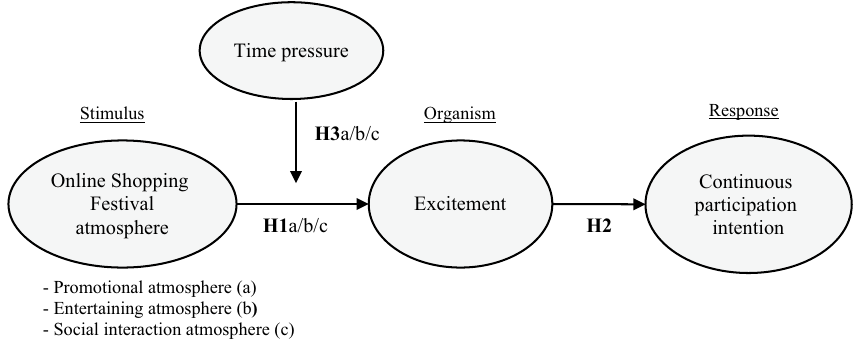
Fig. 1 Conceptual